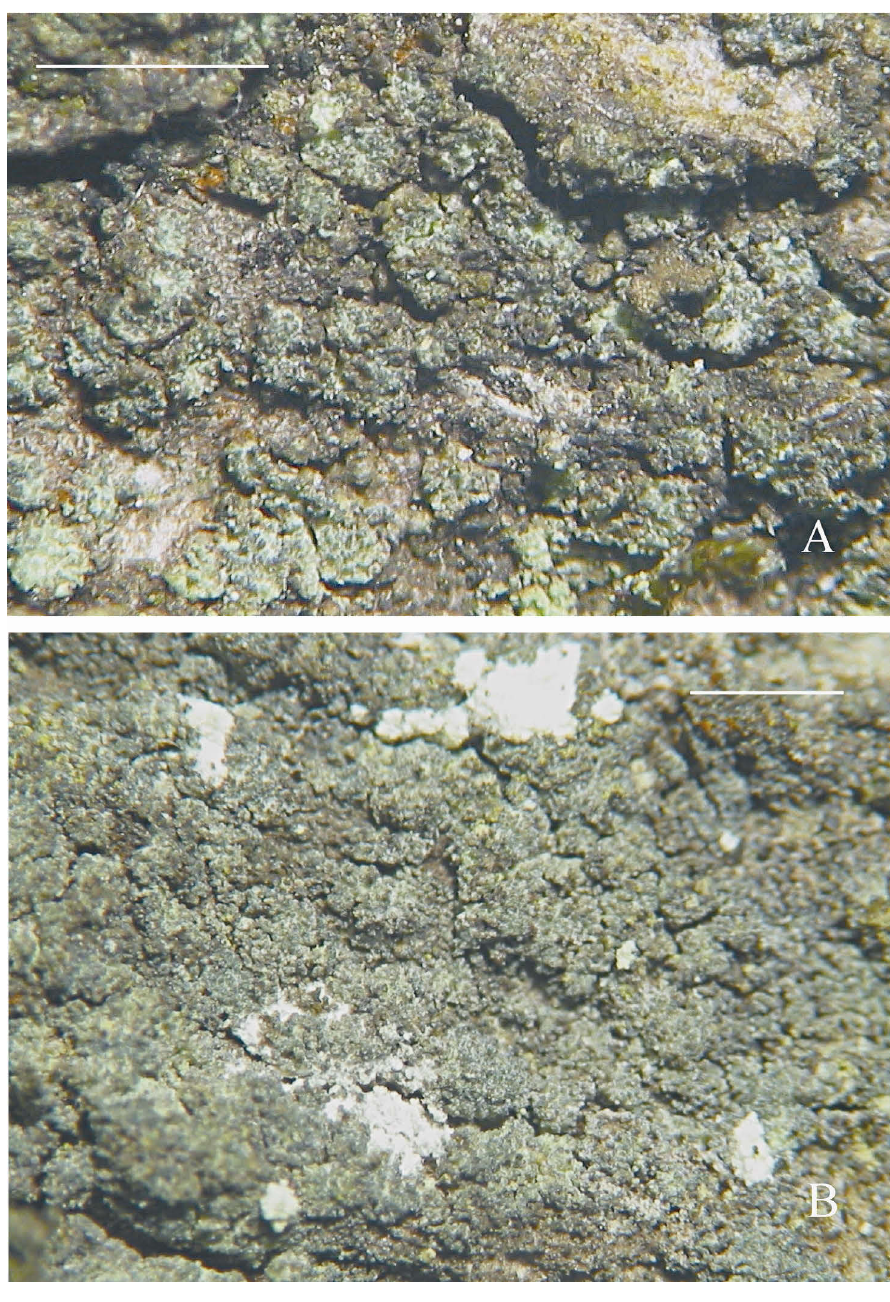
Fig. 1. Habit of Rinodina griseosoralifera (Czarnota 5147, GPN); A – distinct soralia; B – confluent soralia; scale bars = 1